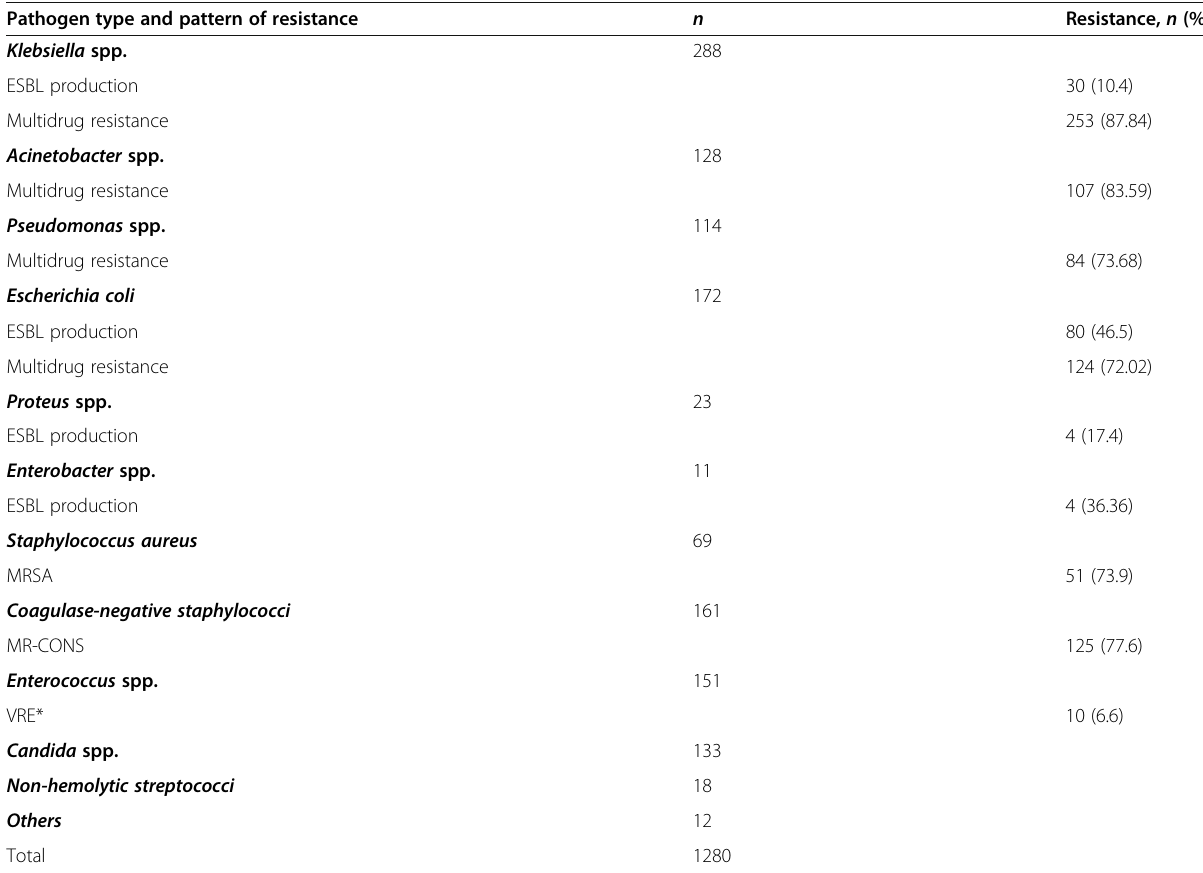
Table 2 Distribution of pathogens associated with intensive care unit-associated infections and their antimicrobial resistance patterns, Ain Shams University Hospitals, Egypt, March 2018 – February 2019 Pathogen type and pattern of resistance n Klebsiella spp.